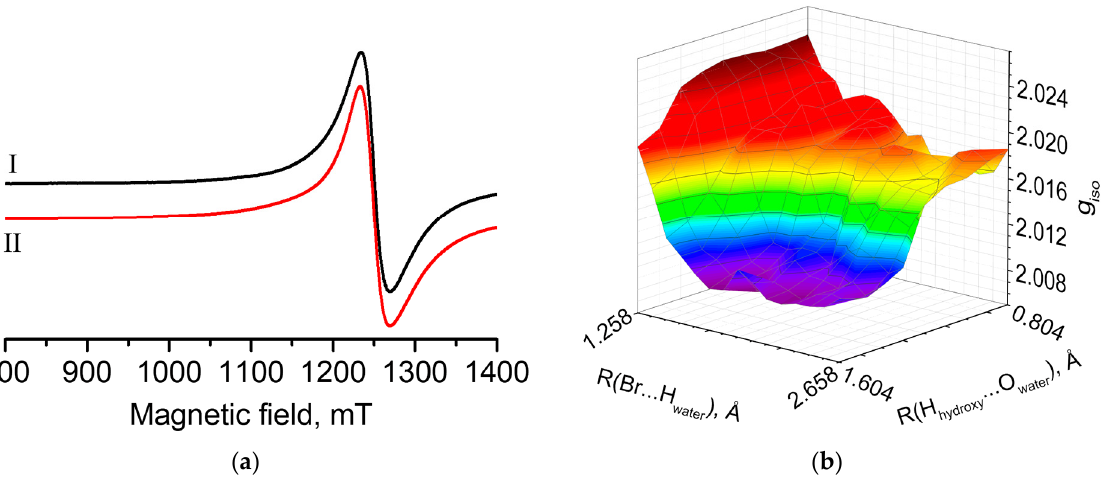
Figure 6. ( a ) EPR spectra of 1 , experimental (I) and as best fit of the experimental data (II) and ( b ) calculated 𝒈 –tensor values along the ground state potential energy surface of 1 . Table 2. Experimental and DFT calculated EPR parameters.